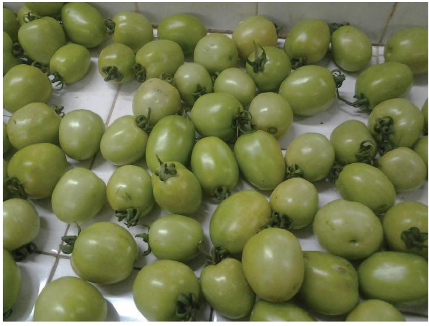
Figure 1: Mature green tomato